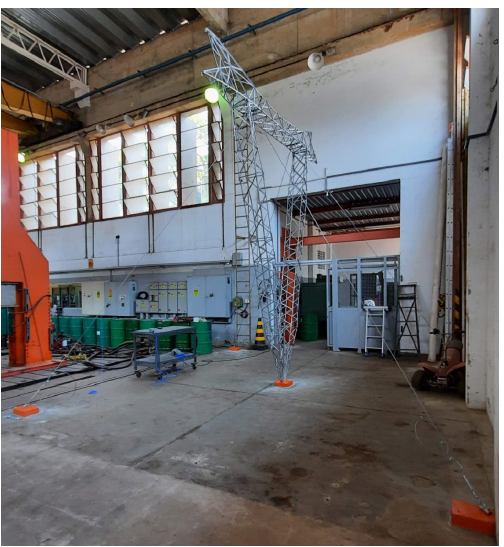
Figure 5. A photo of the mockup tower installed inside the LabEDin mechanical engineering laboratory.